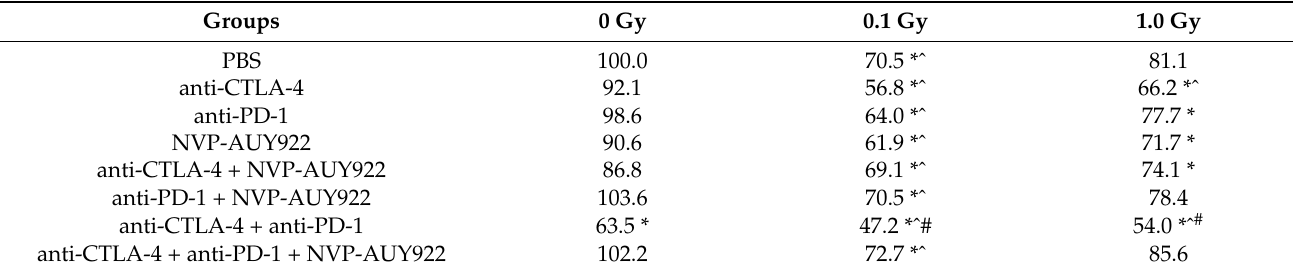
Table 2. Clonogenic capacity (CC) in vitro of tumor cells obtained from the lungs of C57BL/6 mice orthotopically (o.t.) injected with LLC1 cells and treated with blockers of the immune checkpoints and/or HSP90 combined with WBI at total doses of 0.1 and 1.0 Gy. Results are expressed as percentages of the control value